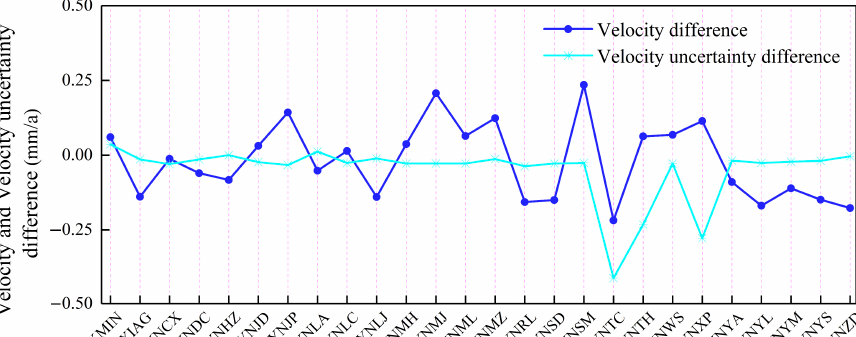
Figure 14. The difference in velocity and velocity uncertainty obtained by optimal noise model before and after HYDL correction.